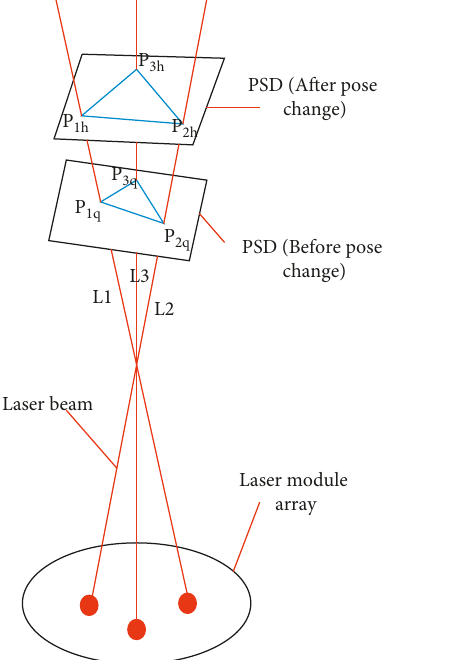
Figure 6: Schematic principle of the subreflector measurement system.